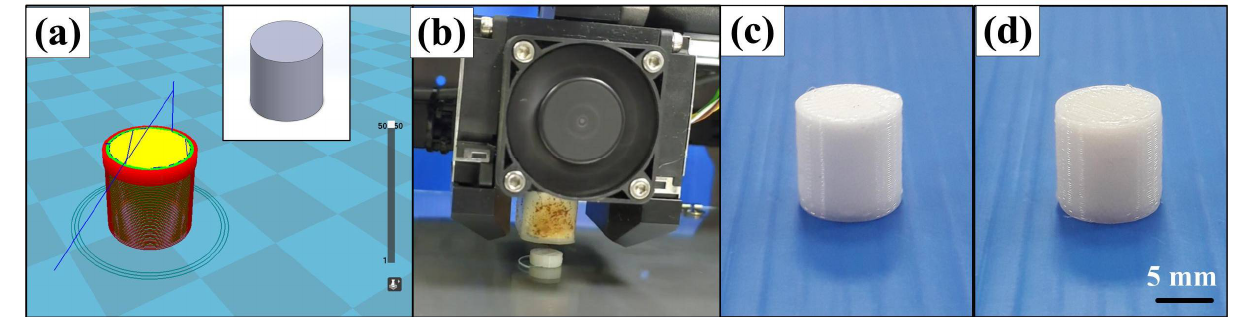
Figure 12. Effectiveness evaluation process ( a ) CAD model of the cylinder and slicing results, ( b ) printing situation of the cylindrical prototype, ( c ) a typical cylindrical prototype built with commercial PLA filaments, and ( d ) a typical cylindrical prototype built with commercially available PLA filament developed in this study.